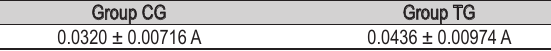
Table 1 - Mean data and standard deviation of absorbance of fuchsin release of the tested groups.